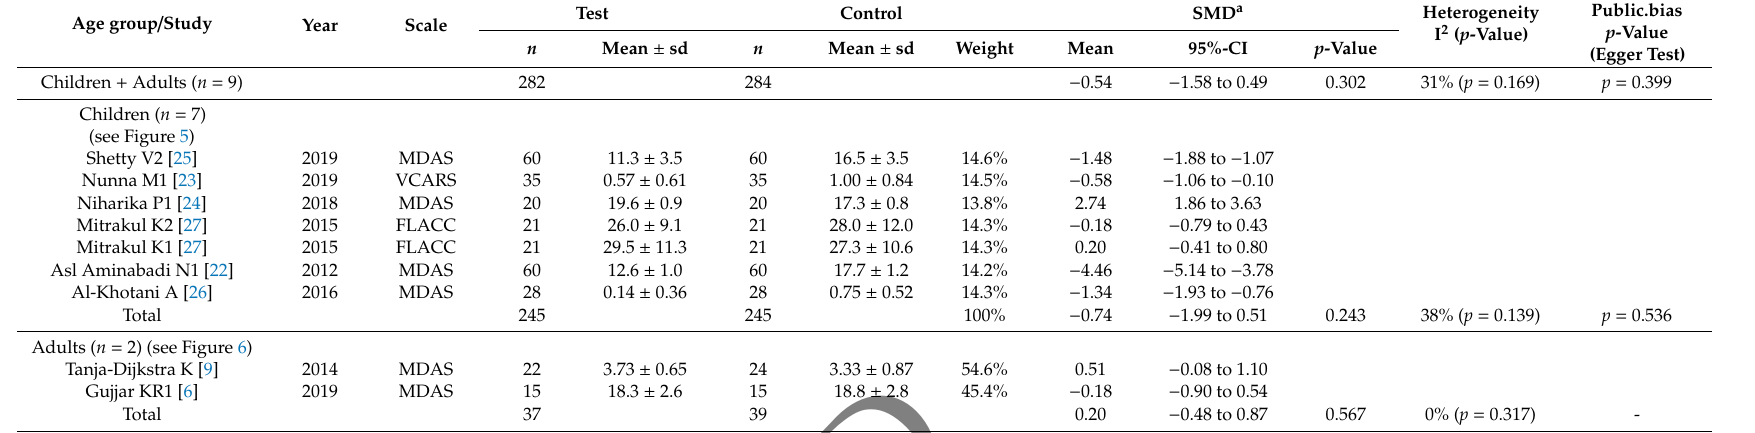
Table 3. Meta-analysis of anxiety. Characteristics of individual studies and meta-analysis. a: Standardized di ff erence of means.